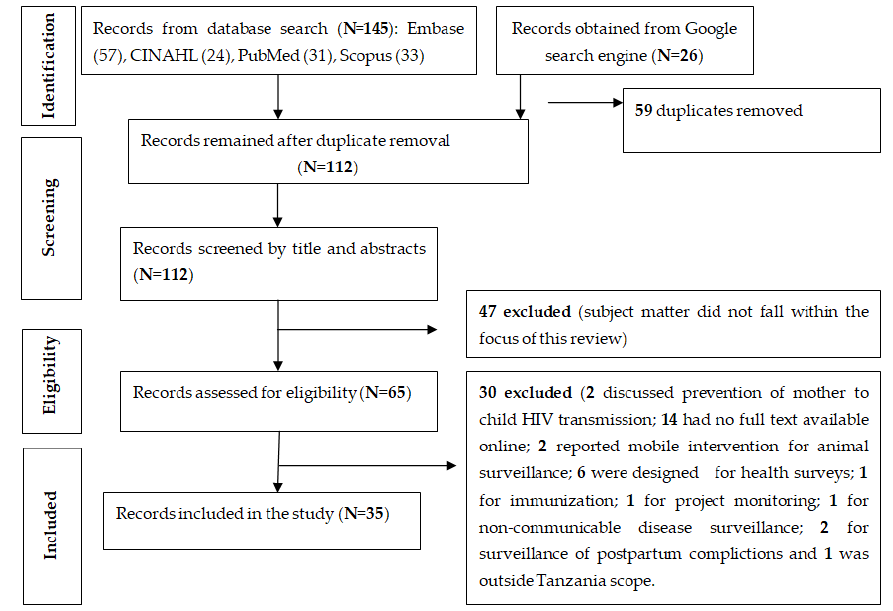
Figure 1. Flow diagram for publication selection process.